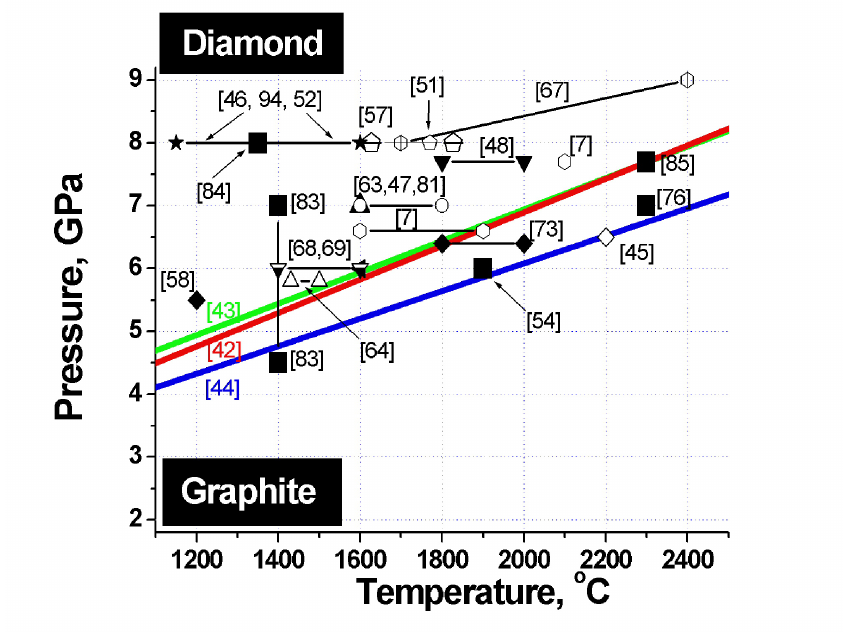
Figure 2. Phase diagram of carbon. Heavy lines - graphite-diamond phase equilibrium lines. Large filled squares - sintering parameters of detonation nanodiamond composites. The other symbols refer to the pressures and temperatures at which samples of microcrystalline diamond differing in size and habitus, both from pure diamond and from its mixtures with titanium, silicon, copper and other binders were obtained. The corresponding references are specified in